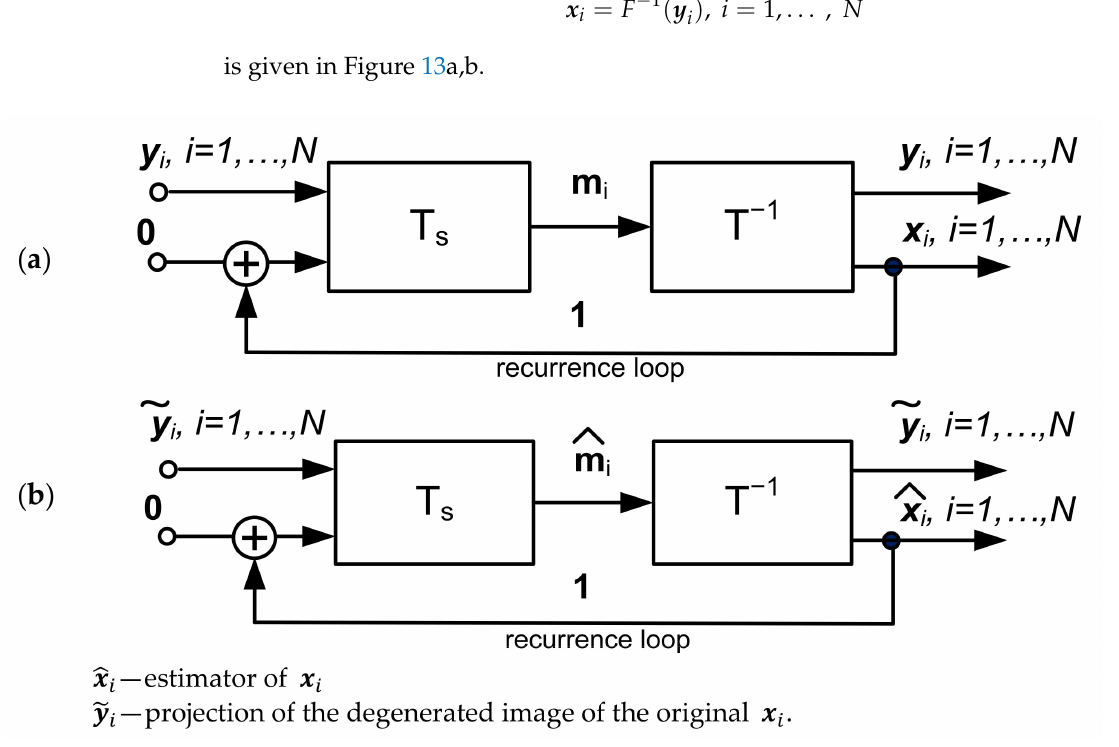
Figure 13. Structure of the system implementing inverse transformation. ( a ) y image projection; ( b ) (cid:101) y —degenerated image i